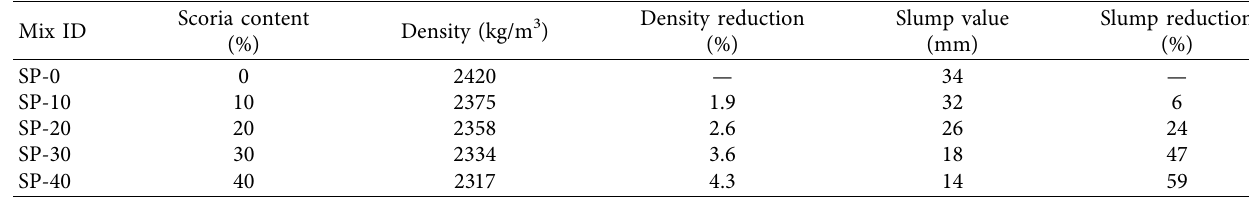
Figure 3: SEM images of the scoria sample at diferent magnifcation sizes. Table 5: Unit weight and slump value of fresh